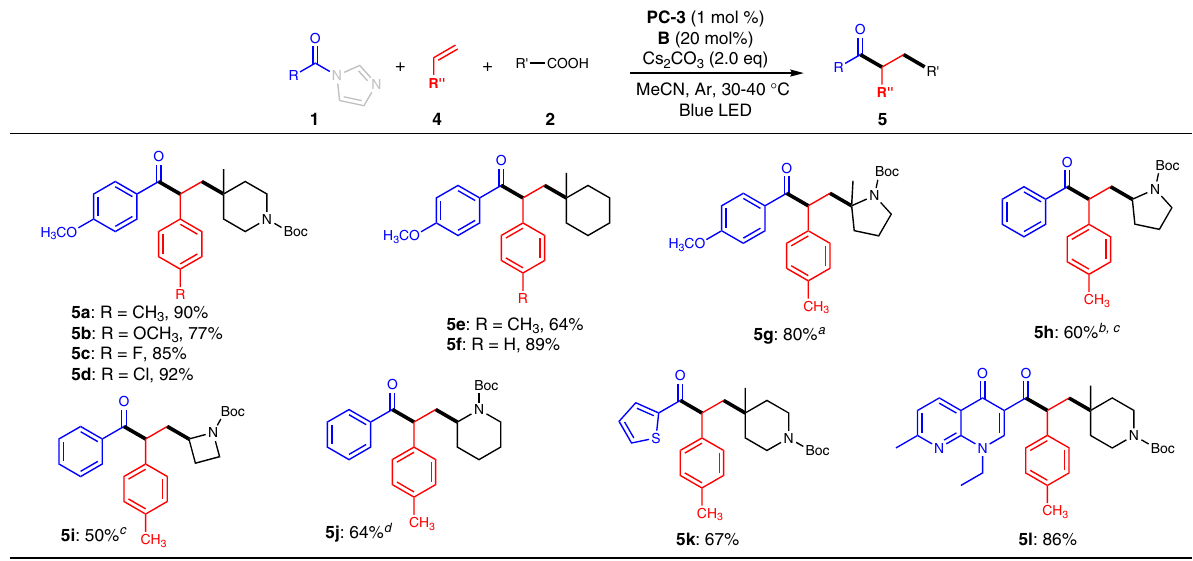
Fig. 4 Examples of three-component radical relay reactions. Reaction conditions: 1 (2.0 equiv), 2 (0.1 – 0.3 mmol, 1.0 equiv), 4 (3.0 equiv), B (20 mol%), PC-3 (1 mol %) and Cs 2 CO 3 (2.0 equiv) in MeCN, blue LED (Kessil PR160 series, λ max = 427 nm), Ar atmosphere, 30 – 40 °C, 24 h. a dr = 1.6/1. b The reaction was set up in 2 mmol scale. c dr = 1.4/1. d dr = 1.9/1.